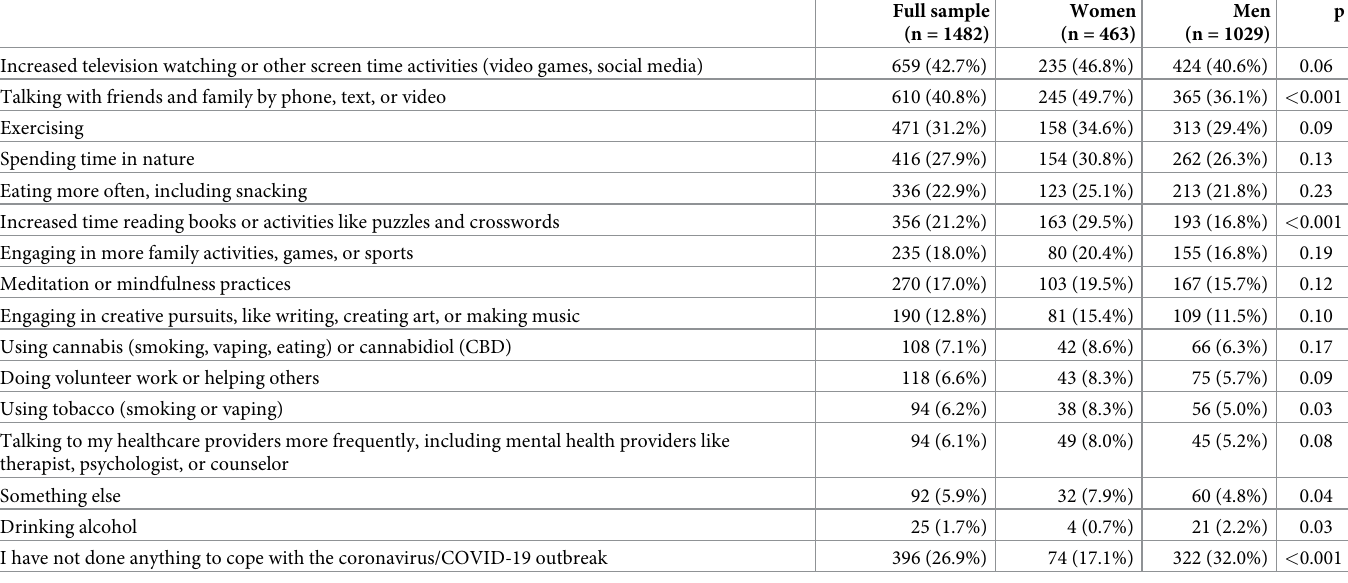
Table 2. Endorsements of coping strategies during the COVID-19 pandemic in a US national sample of adults with a resolved alcohol